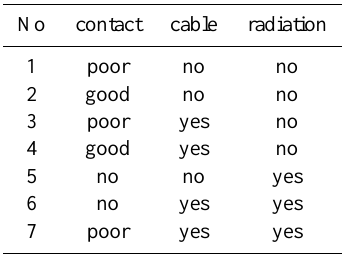
Table 2. Measurement scenarios addressed for each of the three sen- sor geometries and sample